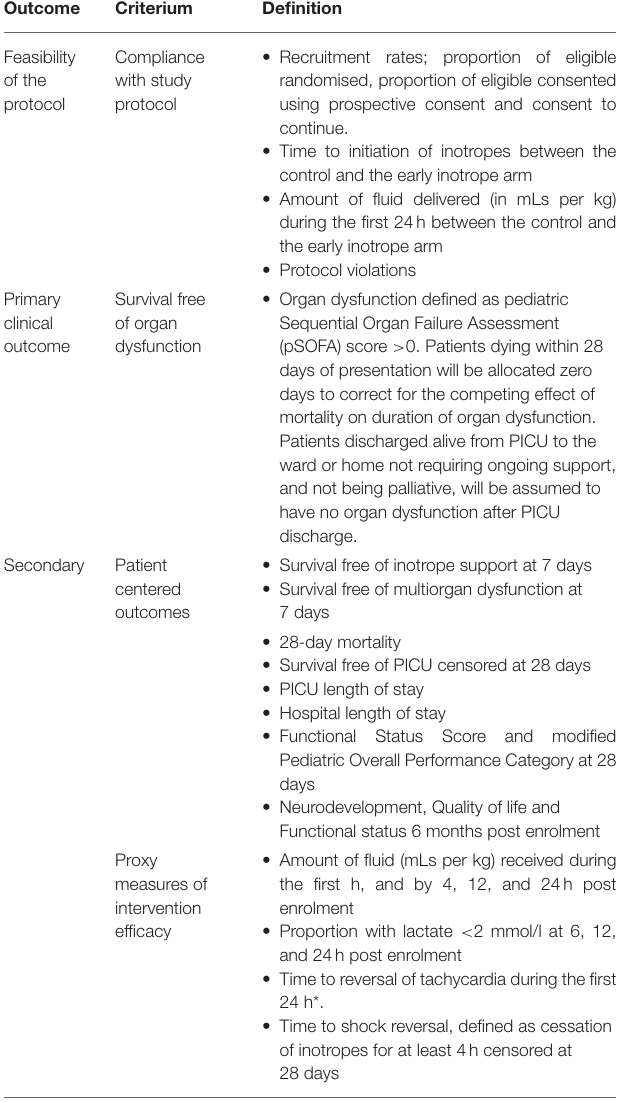
TABLE 2 | Outcomes